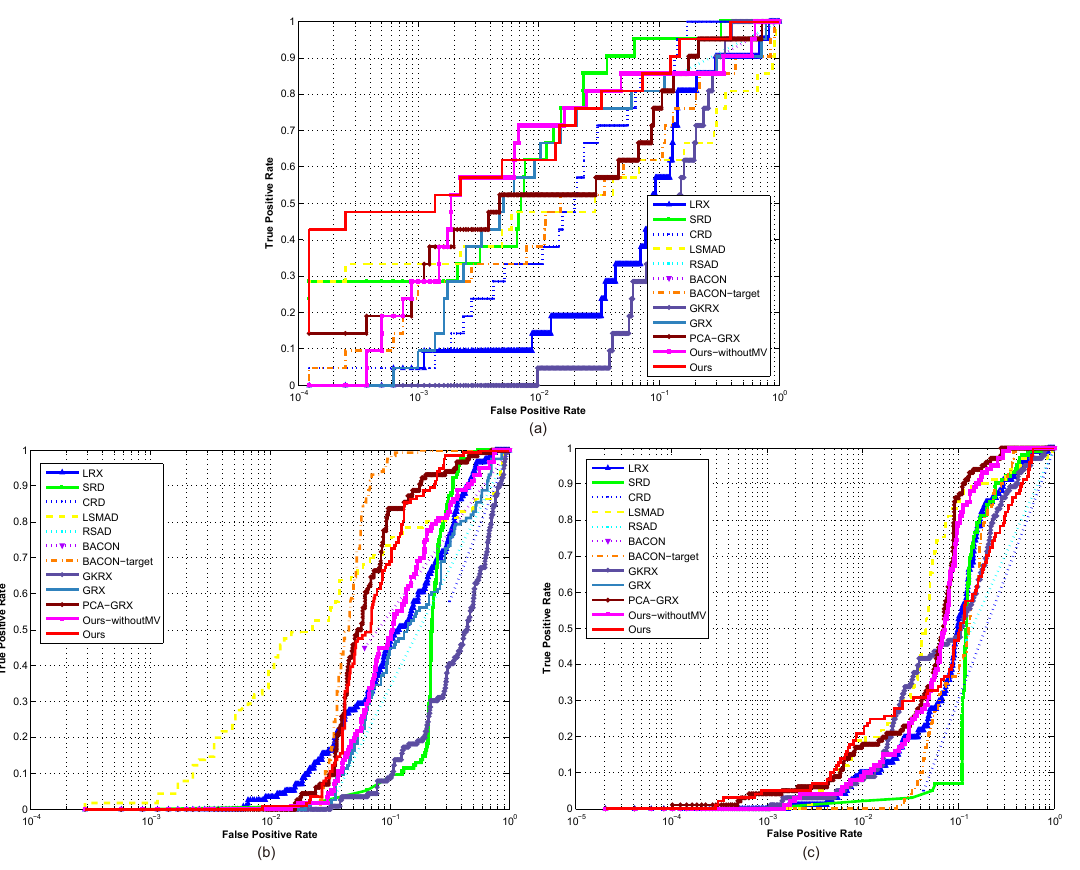
Figure 3. The ROC curves of different detectors on three hyperspectral images. ( a ) Urban data set; ( b ) AVIRIS1 data set; ( c ) AVIRIS2 data set. Table 3. Average AUC and average time consumption (seconds) of each competitors using all the three real-world data